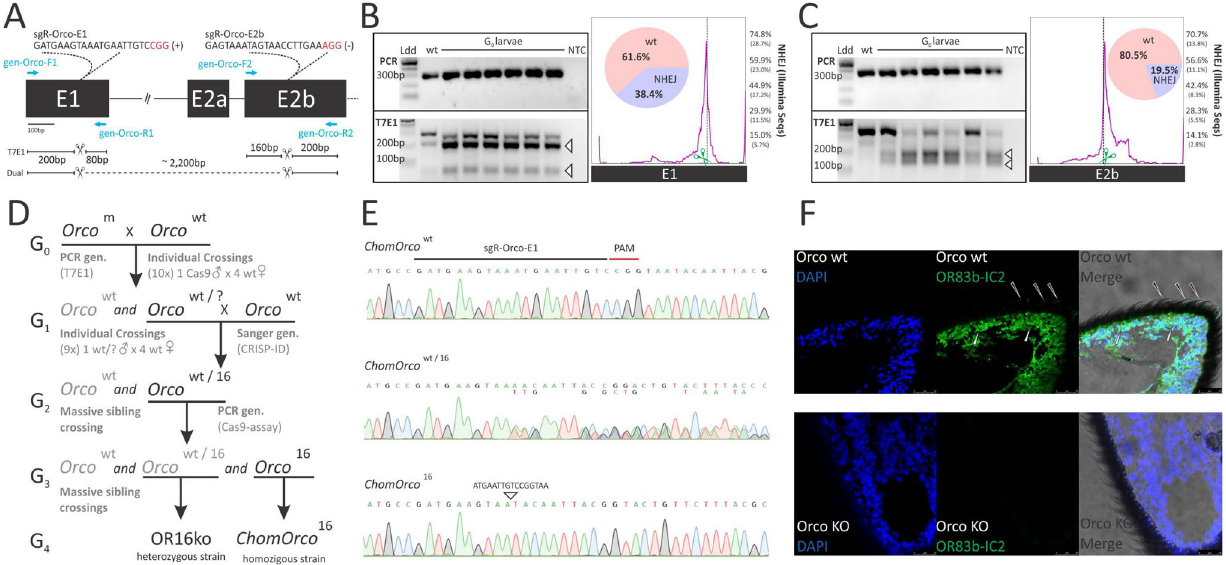
Figure 3. Knockout of ChomOrco by CRISPR/Cas9 induce complete loss of Orco protein in screwworm. ( A ) Schematic of the Cas9-targeted regions of ChomOrco and sgRNAs tested. Targeted sites are indicated by a scissor, PAM motif in red, and genotyping primers as blue arrows. Band migration patterns expected after T7E1 and dual-targeting assays are indicated below. ( B , C ) In vivo evaluation of sgR-Orco-E1 and sgR-Orco-E2b, respectively. A small number of surviving larvae ( n = 6) were collected and genotyped by T7E1 ( leftmost ). PCR amplifications spanning targeted sites were pooled, Illumina sequenced, and genome modifications quantified using CRISPResso ( rightmost chart ). A diversity of allele variations is shown in Supplementary Fig. S3. Cropped images (delineated by black lines) of PCRs and T7E1 experiments are from samples run on the same gels (one for each experiment). Full-length gels are displayed in Supplementary Fig. S5. wt = wildtype sample; NTC = no template control; Ldd = 100 bp DNA Ladder (NEB). ( D ) Crossing scheme used to develop Orco mutant strains. Briefly, G 0 flies were genotyped by T7E1, and mosaic males ( Orco m ) backcrossed to wt females ( Orco wt ). Heterozygous individuals ( Orco wt/? ) at G 1 were genotyped by sequencing, and siblings harboring a − 16 bp mutation inbred at G 2 . Heterozygous ( Orco wt/16 ) and homozygous ( Orco 16 ) flies at G 3 were identified by in vitro Cas9-assay (Supplementary Fig. S8) and inbred to establish the heterozygous (OR16ko) and homozygous ( ChomOrco 16 ) strains. ( E ) Sequencing confirmation of the mutant genotypes in comparison with the wt allele. ( F ) Immunostaining of antennae sections from wt ( above ) and ChomOrco 16 (KO, below ) flies, showing cell nuclei (DAPI) and Orco protein (OR83b-IC3) localization within cell body (white arrows) and dendrites (black arrows) of screwworm’ OSNs. As in control slides (Supplementary Fig. S9), mutant flies display undetectable levels of Orco